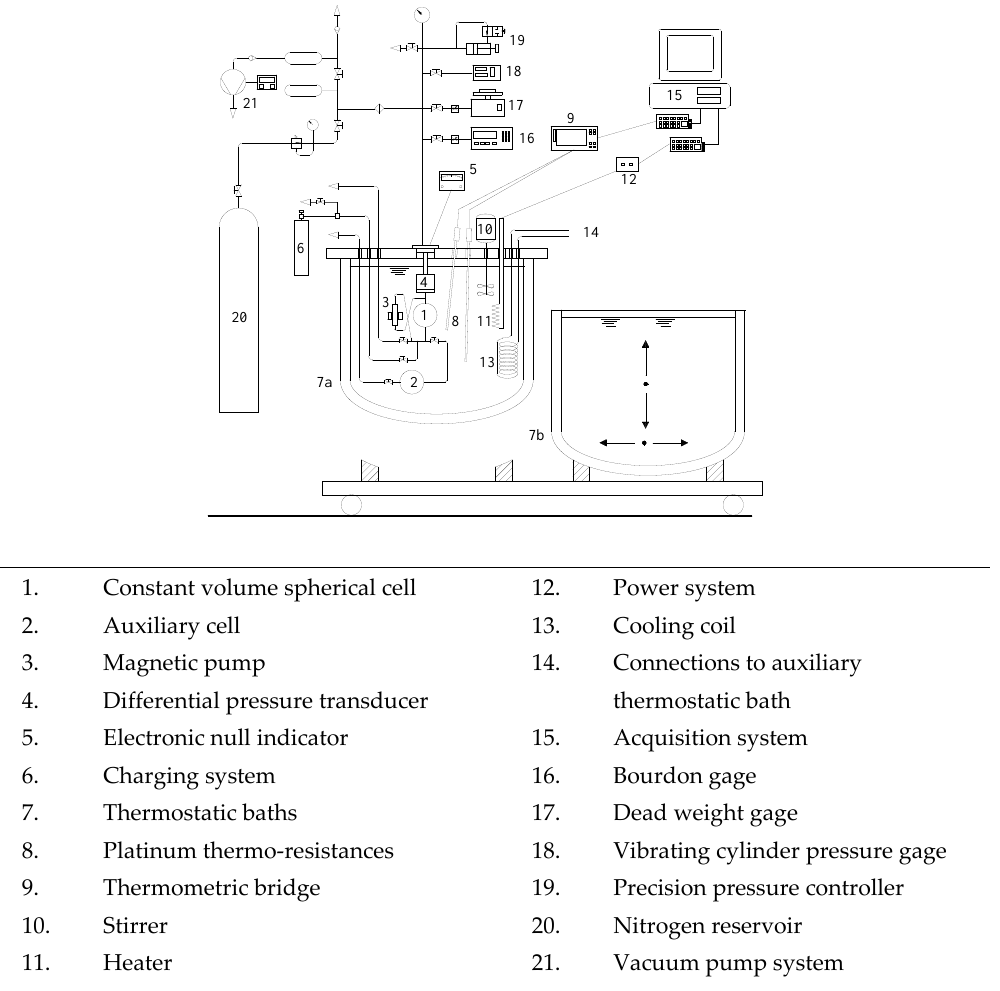
Figure 1. Schematic view of the isochoric